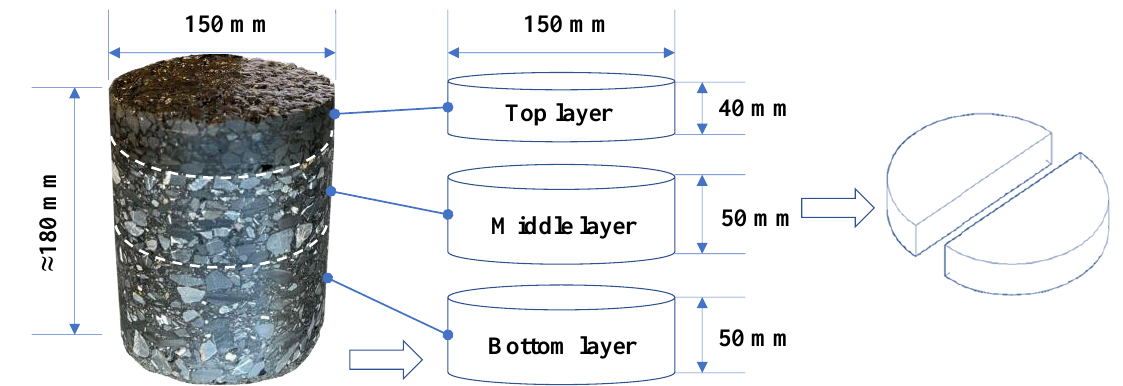
Figure 3. Schematic of SCB specimen preparation for the three asphalt layers. As shown in Figure 4, a UTM-25 (IPC, Melbourne, Australia) universal testing system with a bend test fixture was utilized in this study, which could deliver loads in compres- sion with a resolution of 10 N and maximum capacity of 25 kN. The SCB test was con- ducted according to AASHTO TP 124 [21]. Figure 4c shows the schematic of the specimen under the SCB test. The distance between the two roller supports at the bottom of the sample is 0.8 times the diameter of the semi-circular specimen, which is 120 mm in this study. The top of the specimen is the load actuator. Before the test, the specimens were kept in an environmental chamber at 25 °C for more than 4 h to ensure that the internal temperature of the specimen also reaches 25 °C, which is the test temperature. The test was conducted using displacement control at a rate of 50 mm/min and the applied load was measured.